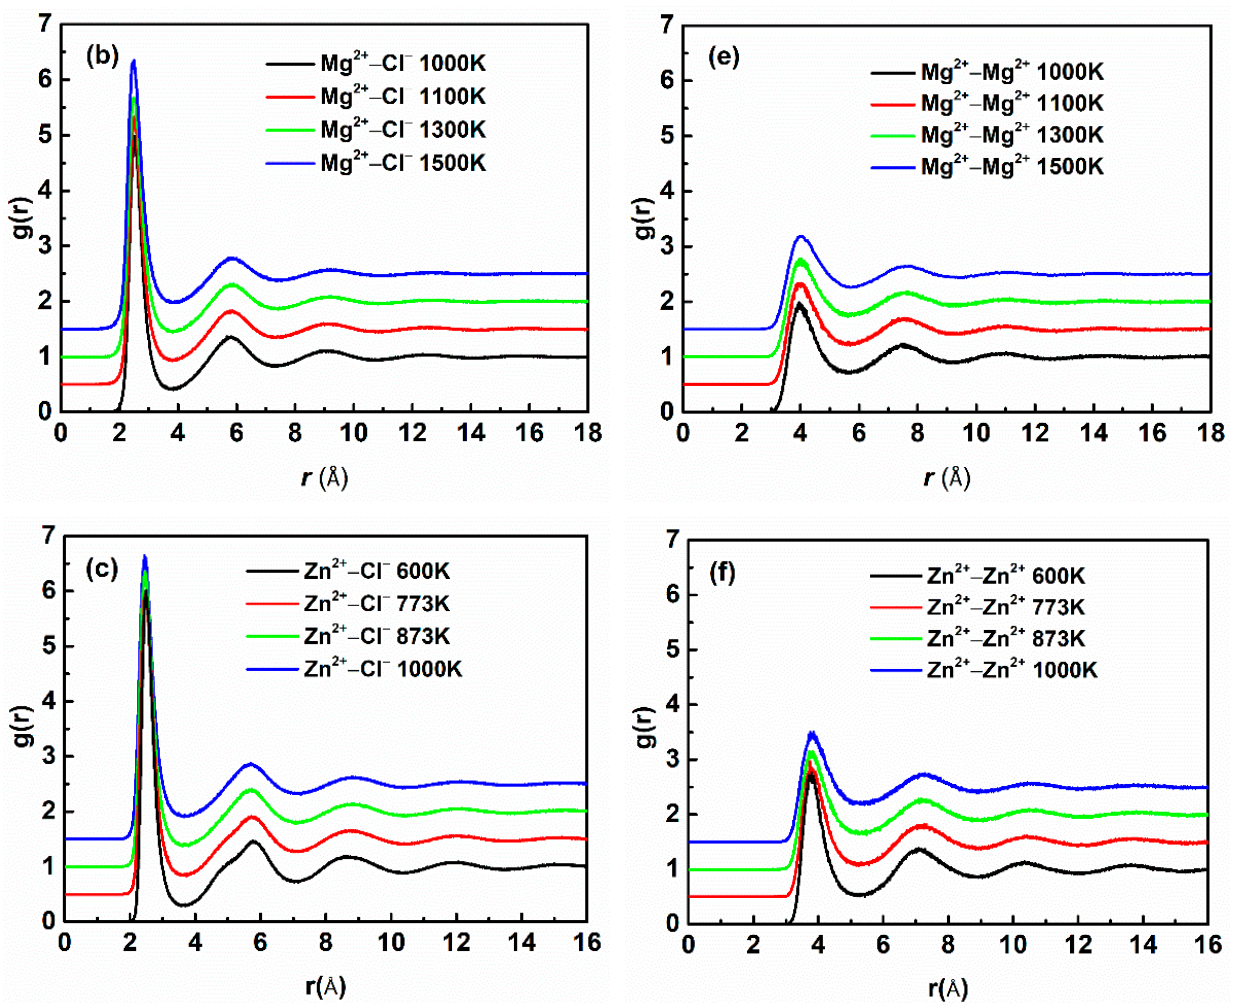
Figure 1. PIM simulated results of RDF: (i) The RDF of cation–anion in PIM ( a ) NaCl; ( b ) MgCl 2 ; ( c ) ZnCl 2 . (ii) The RDF of cation–cation in PIM ( d ) NaCl; ( e ) MgCl 2 ; ( f ) ZnCl 2 .